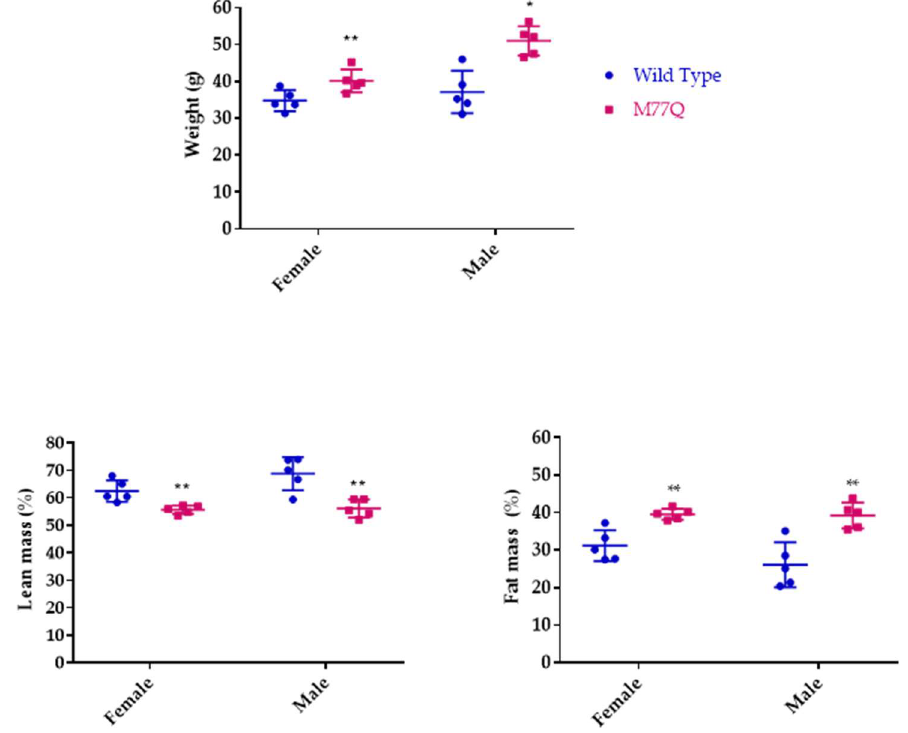
Figure 5. Body composition of mice at 18 months of age. There were 5 mice in each group. (* p < 0.05, ** p < 0.01 by t -test).